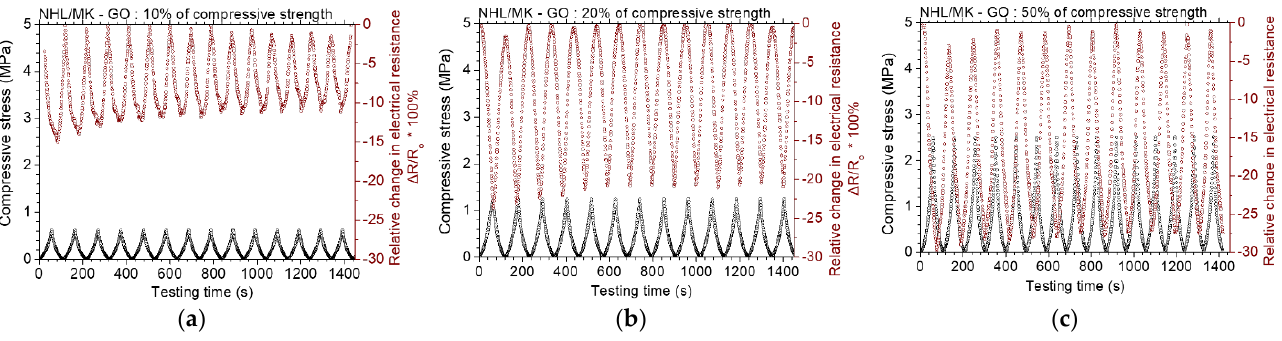
Figure 10. Cyclic, piezoresistive response of GO reinforced binary paste at constant amplitude level of ( a ) 10%, ( b ) 20% and ( c ) 50% of the compressive strength of the paste.